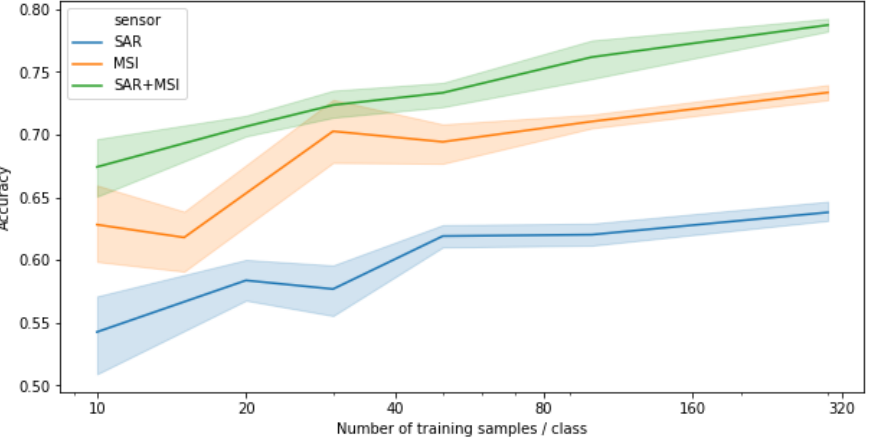
Figure 10. Data integration vs single-source classification on a Random Forest classifier. The inte- grated solution clearly outperforms both MSI and SAR alone for all training set